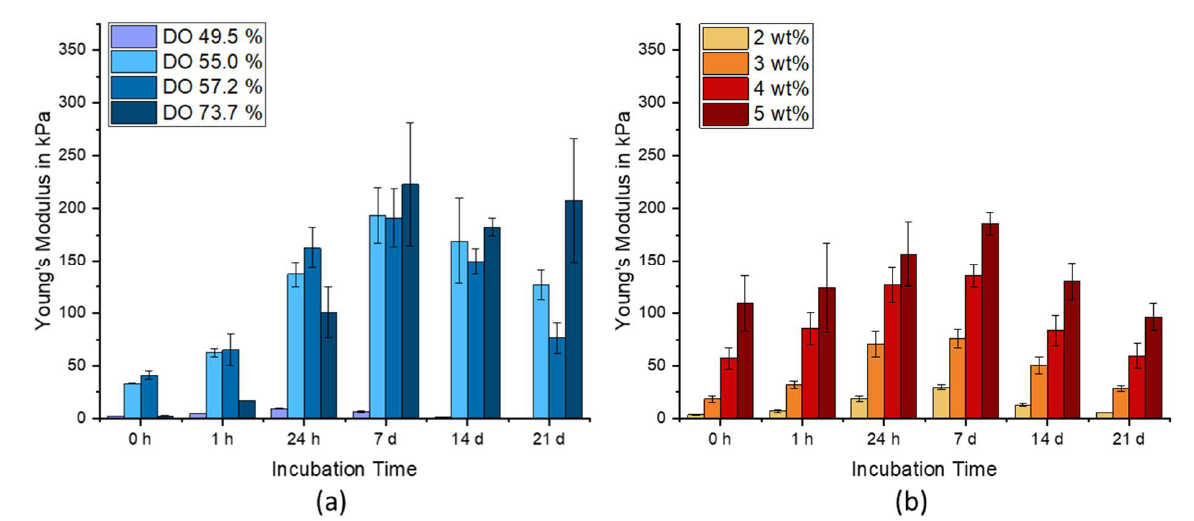
Figure 3. Young’s moduli of: ( a ) Various batches with DO 49.5%, 55.0%, 57.2%, and 73.7% and a polymer content of 3 wt%; ( b ) the mixed polymer blend (DO 53.3%).